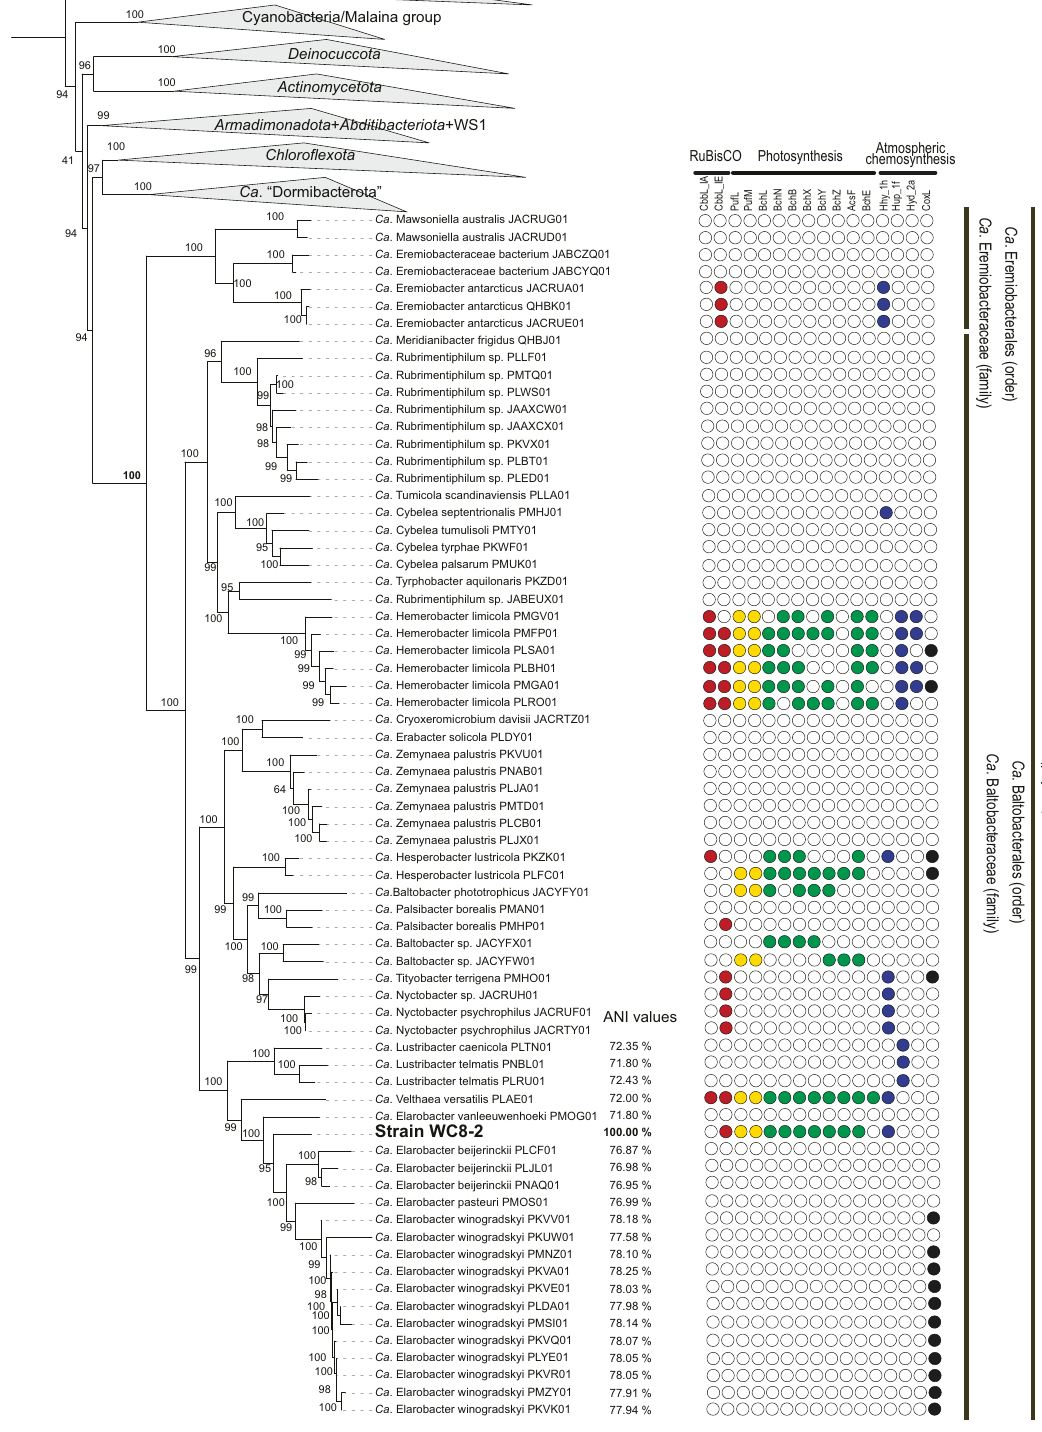
Fig. 1 Phylogenomic tree of strain WC8-2 within the Terrabacteria group based on 400 marker protein sequences, with the presences of genes encoding speci fi c proteins involved in carbon fi xation, phototrophy, and “ atmospheric chemosynthesis ” tabulated. The phylogenetic tree was reconstructed using IQ-tree to produce maximum-likelihood trees with 1,000 bootstraps. Bootstrap support is shown as a solid black circle for nodes with greater than 80% support. The presence of the following genes is indicated with a color- fi lled circle: red for RubisCO (CbbLS), yellow for photoreaction center proteins (PufML), green for BChl synthesis protein (BchLNBXYZE, and AcsF), blue for group 1 and 2 [NiFe]-hydrogenases large subunit (group 1h_Hhy, group 1f_Hup, and group 2a_Hyd), and black for carbon monoxide dehydrogenase (CoxL). The scale bar represents substitutions per nucleotide base. The MAGs information used in this tree is shown in Table